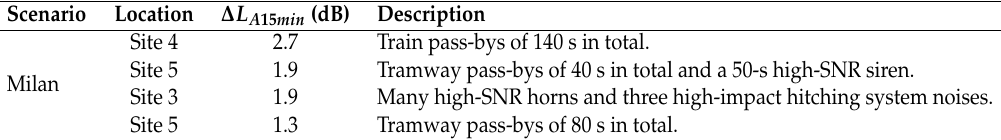
Table 2. Detail of the highest impact of aggregated ANEs on L A 15 min within the Milan urban area for different recording